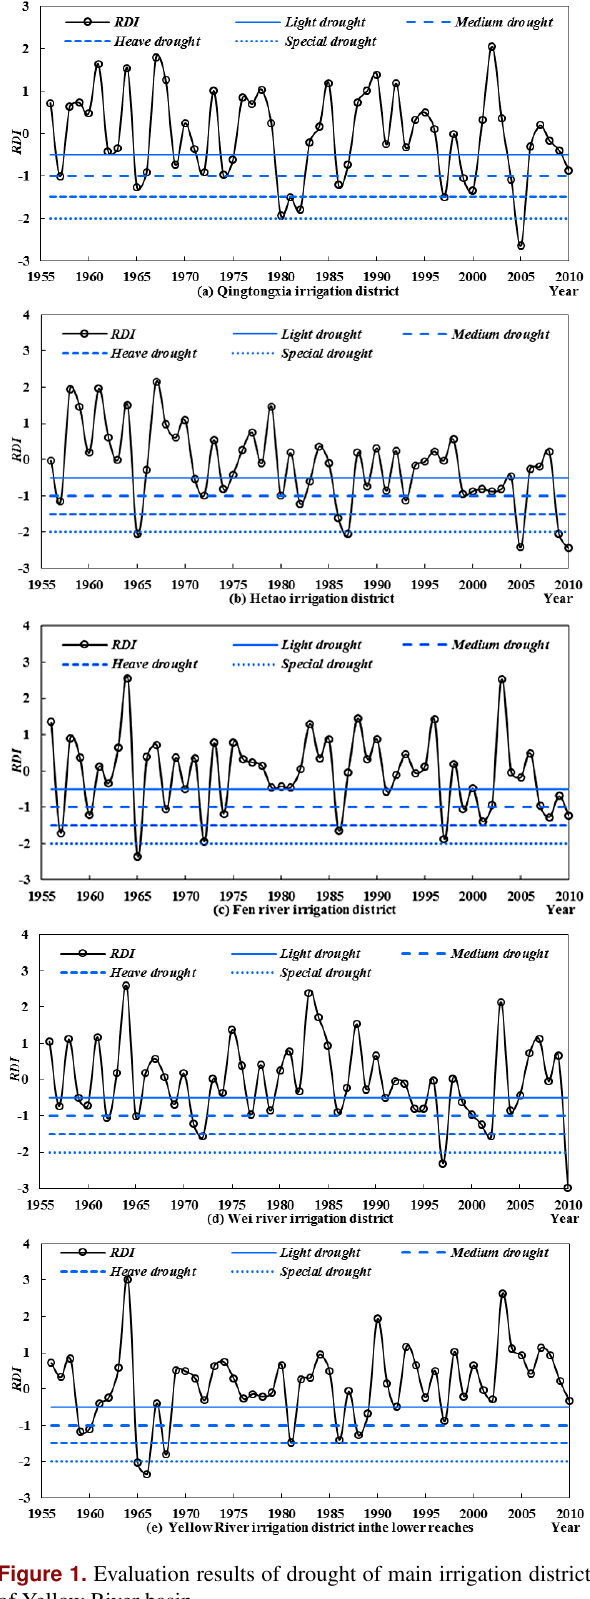
Figure 1. Evaluation results of drought of main irrigation districts of Yellow River